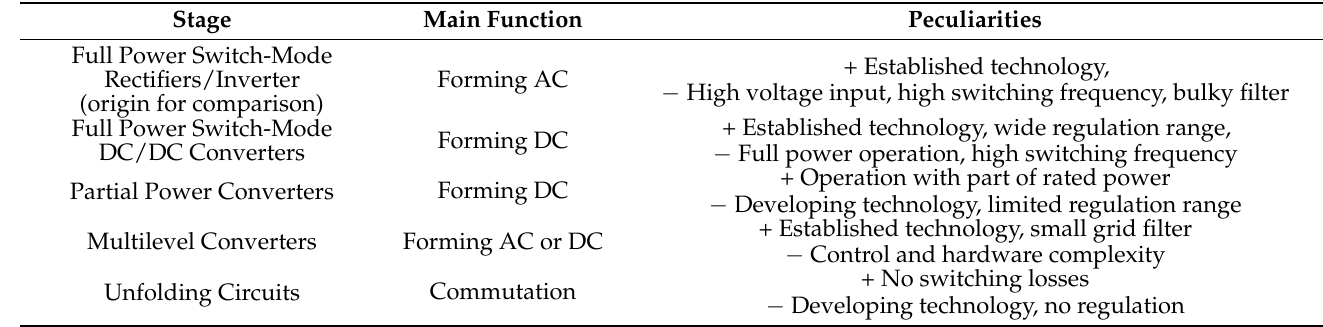
Table 3. Losses of converters and energy conversion principles in BESS grid interface.